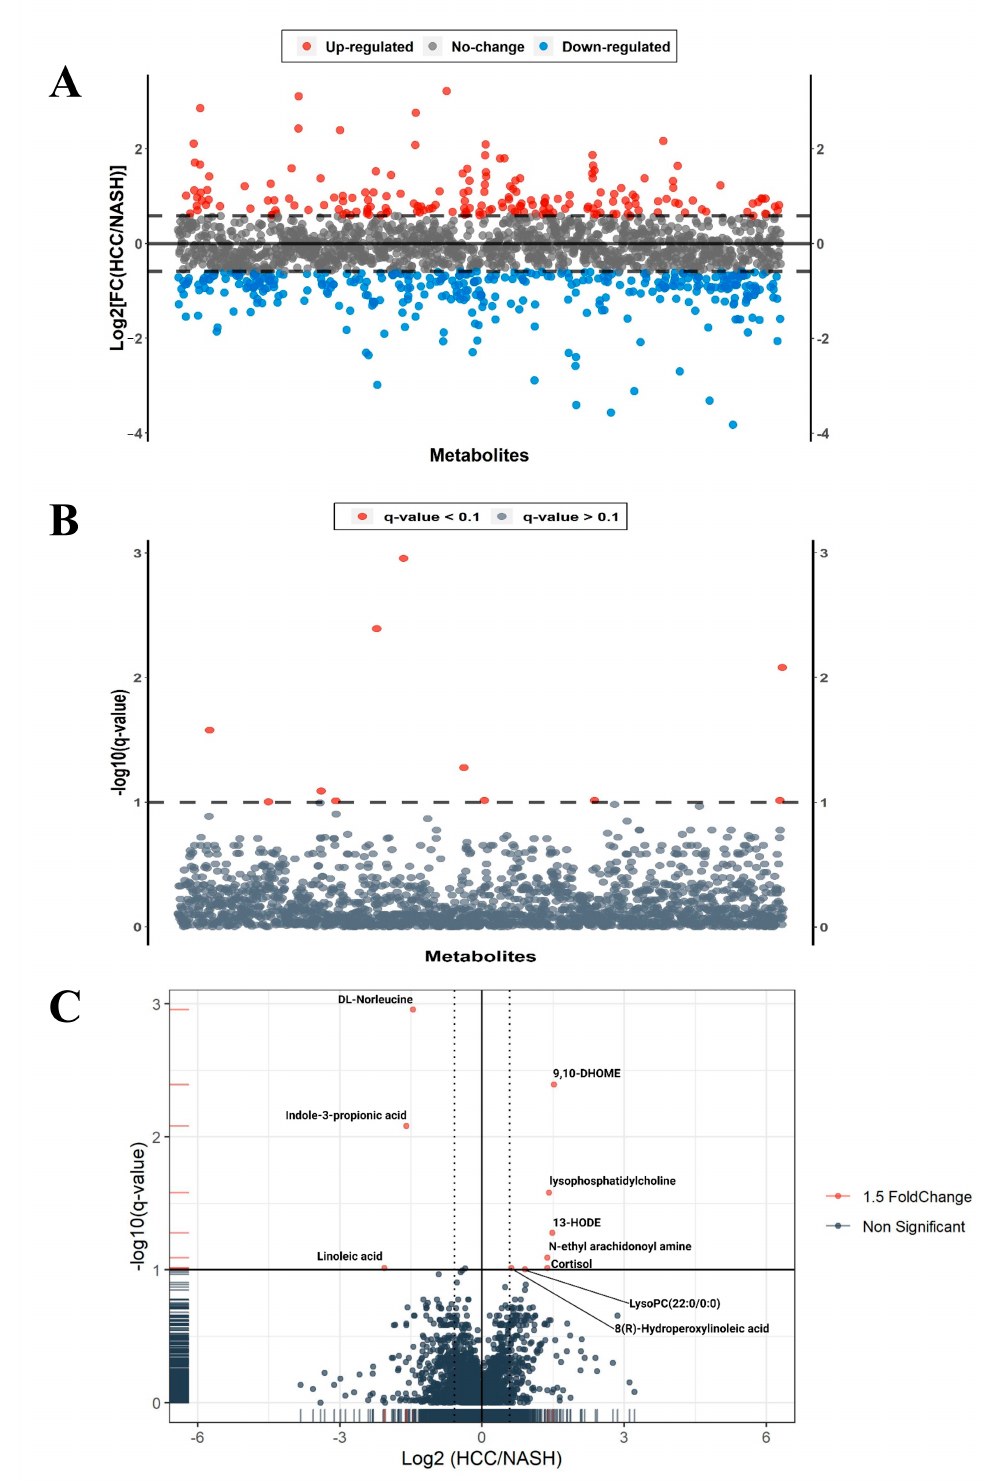
Figure 1. ( A ) Upregulated and down-regulated metabolites with fold change ± 1.5 in NASH-HCC patients when compared to NASH patients. ( B ) Wilcoxon (Mann–Whitney) test with FDR 10% (q-value) and p -value < 0.05, and 11 metabolites were detected to be significantly (red dots) expressed differently between the two groups. ( C ) Volcano plot with fold change between the groups equal to 1.5 (and − 1.5) and alpha value p ≤